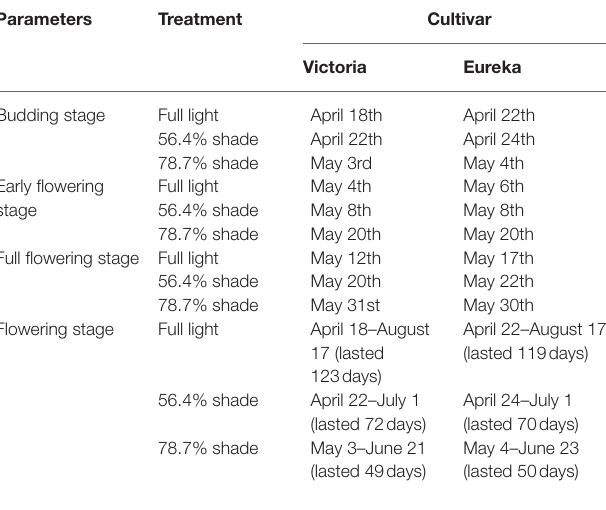
TABLE 1 | Flowering phenology of two alfalfa cultivars under different shading levels.